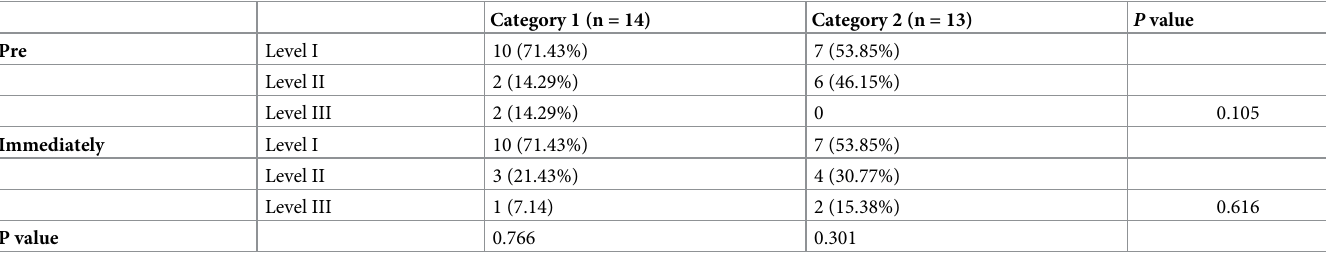
Table 5. Comparison of the bilateral bite force deviation (before treatment vs immediately following